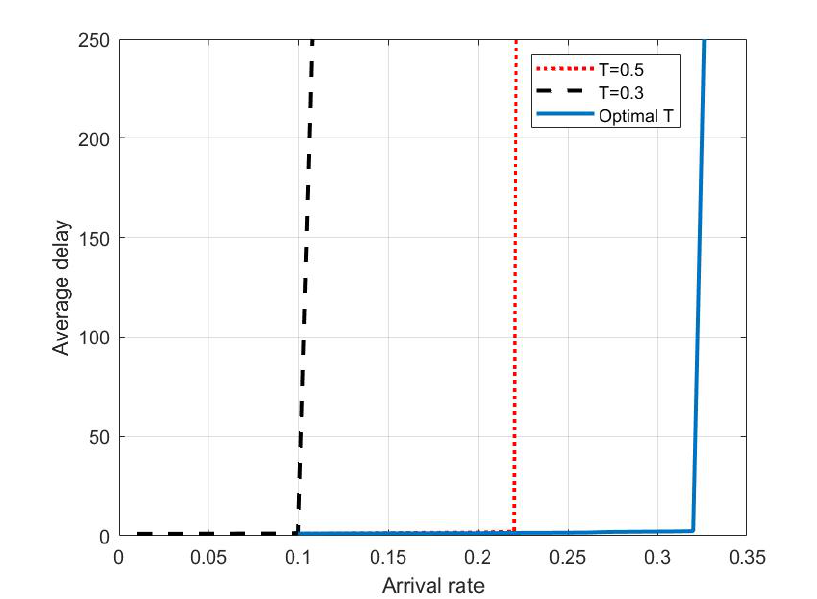
Figure 9. Delay vs. arrival